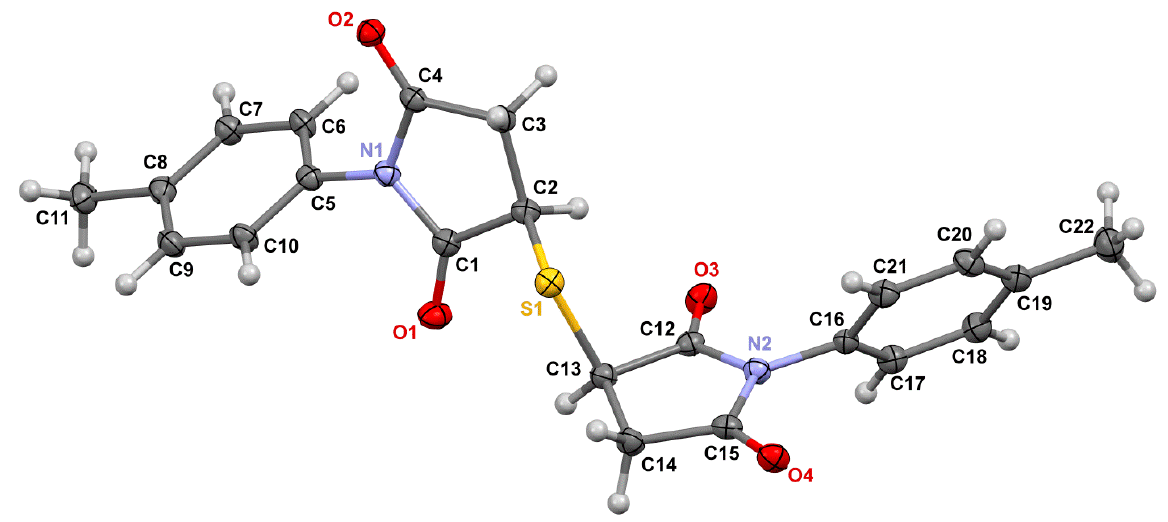
Figure 1. Molecular structure of 3,3 ′ -thiobis (1-p-tolylpyrrolidine-2,5-dione) 3b ( p = 50%). The dihedral angle between planes defined by atoms of the aromatic ring (C6) and atoms of the C(=O) N C(=O) fragment is 64.3(1) ◦ for atoms C5, . . . , C10 and O1, C1, N1, C4 and O2 and 59.9(1) ◦ for C16, . . . , C21 and O3, C12, N2, C15 and O4. Therefore, tween two neighboring molecules of DMSO or neighboring molecules of DMSO and 3b .